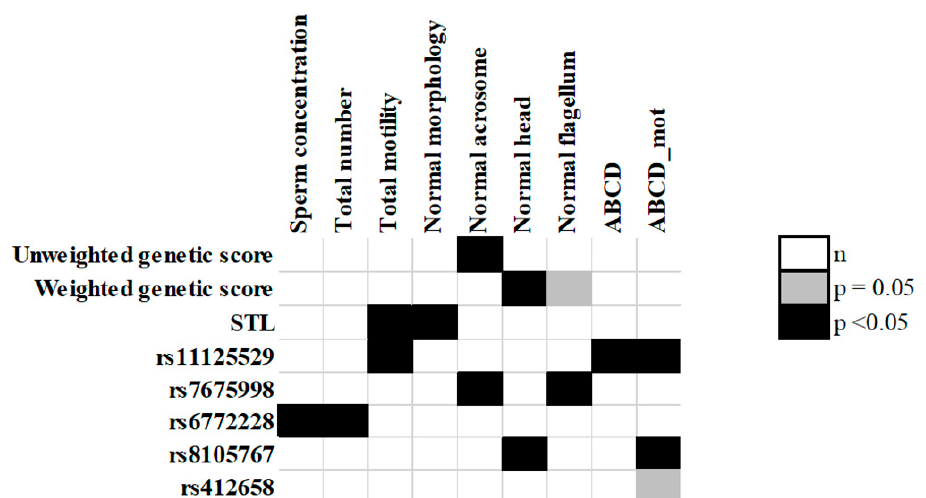
Figure 1. Heatmap of the results of association analyses between sperm parameters and telomere length. Analyses performed using a generalized linear model adjusted by age and smoke status, including the reaction plate as randomic effect variable. In black the association that reported in at least one analysis model a p value < 0.05, in dark grey the suggestive associations with a p value equal 0.05 in at least one analysis model.